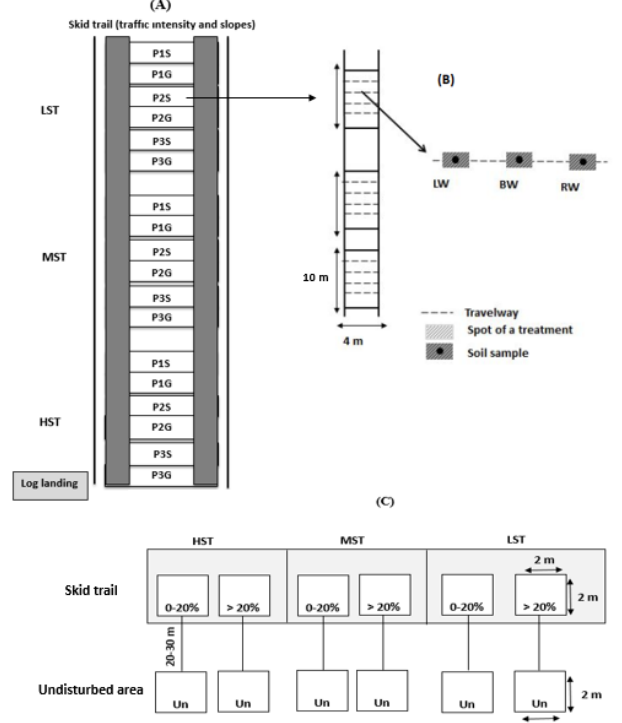
Figure 1. Sketch of the sampling design; ( A ) Plot locations along the skid trails with wheel tracks shown in treaded imprints underlying the sampling plots. HST = skid trail with high tra ffi c intensity, MST = skid trail with medium tra ffi c intensity, LST = skid trail with low tra ffi c intensity. Each skid trail had several replicates of both steep and gentle slopes; P1S = 1st replicate on steep slope, P3G = 3rd replicate on gentle slope. In the field, HST, MST, and LST were di ff erent branches of the skid trail and were located much further apart. ( B ) Enlarged sketch of one sample plot with the dimensions of 10 m by 4 m and the location of the nearby undisturbed control plot (Un) that is associated with each sample plot. LW = left wheel track, BW = between wheel tracks, RW = right wheel track. ( C ) Plot design for tra ffi c intensities and slopes in the skid trail to compare the regeneration of tree species with the undisturbed